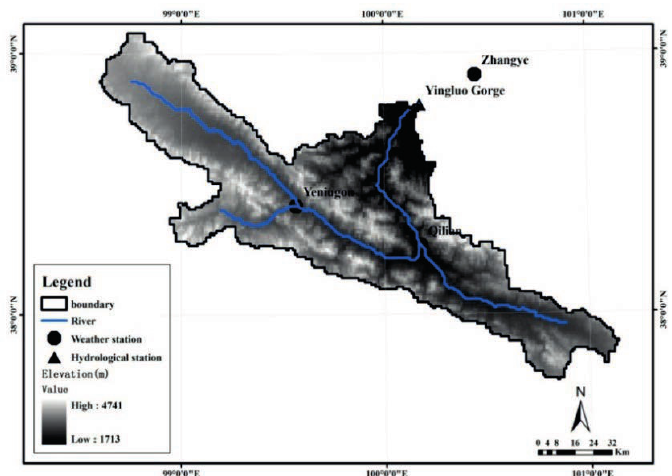
Fig. 1 Topography, weather stations and hydrological station of the upper Heihe